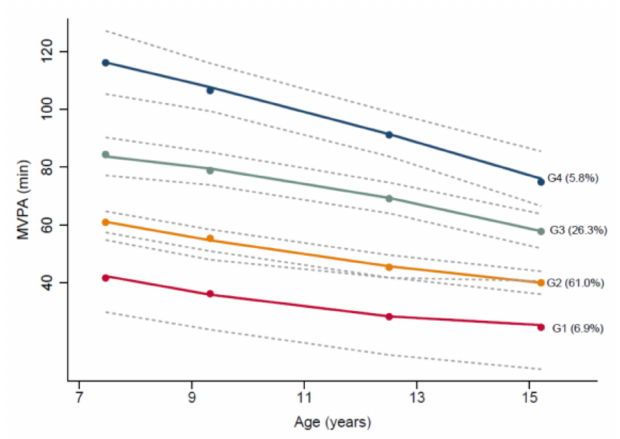
Figure 1. Group based trajectories of time spent in MVPA. Dots indicate average MVPA (minutes/day), and four black lines are trajectories showing estimated mean MVPA (minutes/day) across age for the four groups identified (G1–G4), and grey dashed lines represent the 95% confidence intervals for each trajectory.